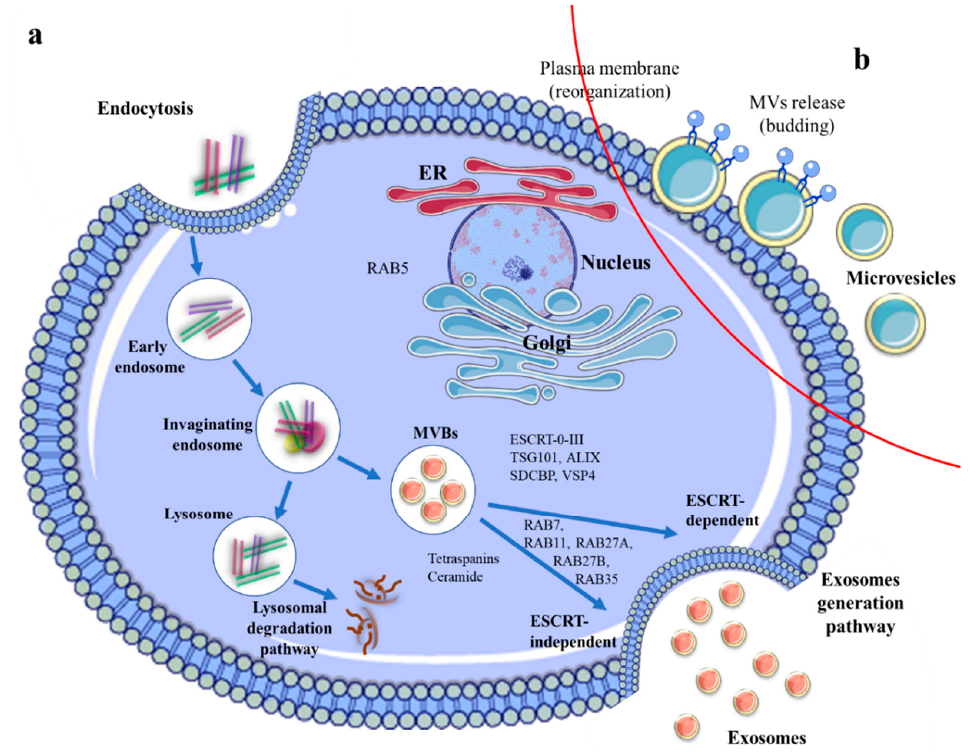
Figure 2. Biogenesis mechanism of ( a ) exosomes and ( b ) MV, and their release processes which are coordinated through two different intracellular pathways, such as exosomes generation pathway and lysosomal degradation pathway. The exosomes formation starts with an active process, called endocytosis, where the cells internalized the material in the extracellular fluid to form internal vesicles (early and late endosomes). Through the inward budding of the late endosomal membrane, multivesicular bodies (MVBs) are formed. Moreover, MVBs can fuse with the lysosomes where their content is degraded or can traffic and fuse with the plasma membrane to release the content into the extracellular matrix. The exosomes generation pathway can be regulated through ESCRT-dependent or via ESCRT-independent pathway. Both processes, (MVBs fusion with the plasma membrane and exosomes release) use for regulation Rab GTPases (Rab7A < Rab11, Rab27A, Rab27B, and Rab35) and SNARE protein complex.